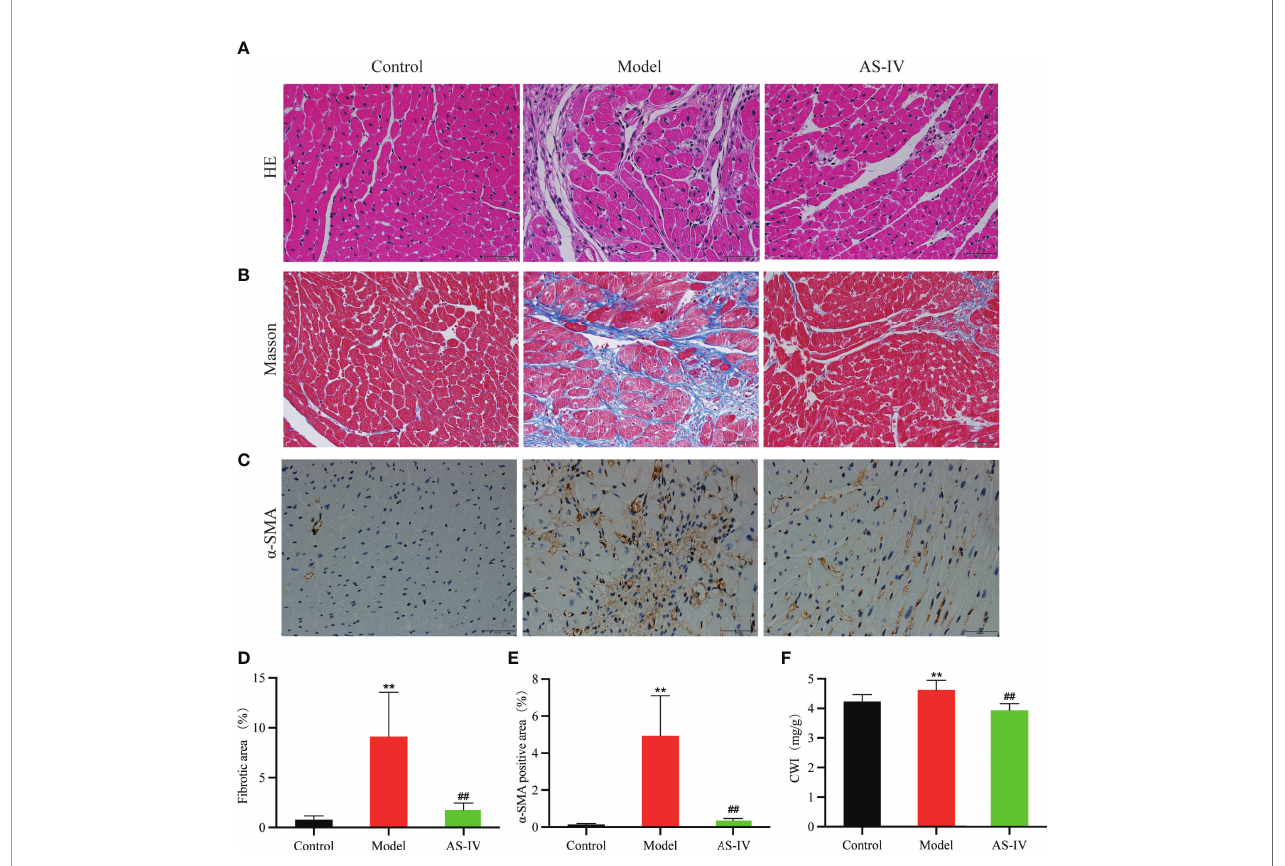
FIGURE 4 | Effects of AS-IV on ISO-induced histopathological changes and cardiac fi brosis. (A – C) Representative images of cardiac fi brosis re fl ected by HE, Masson, and immunohistochemical staining. (D, E) Quanti fi cation of interstitial fi brosis and a -SMA (n = 8). (F) CWI. Mean ± SD. ** P < 0.01(the control vs. the model group). ## P < 0.01 (the AS-IV vs. the model